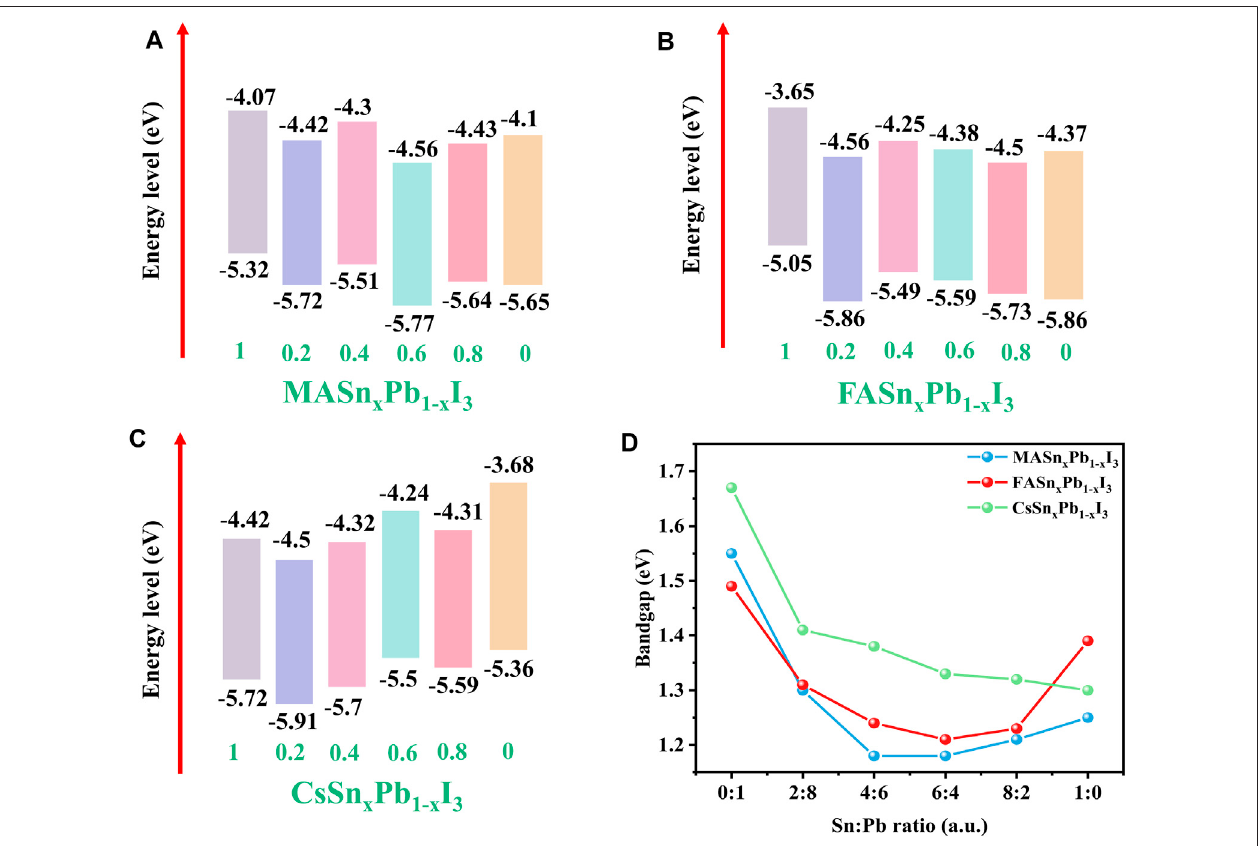
FIGURE3| Energylevels of (A) MASn x Pb 1-x I 3 , (B) FASn x Pb 1-x I 3 and (C) CsSn x Pb 1-x I 3 wherex=1,0.2,0.4,0.6,0.8,0; (D) relationshipbetweenbandgapandSn: Pb ratio.